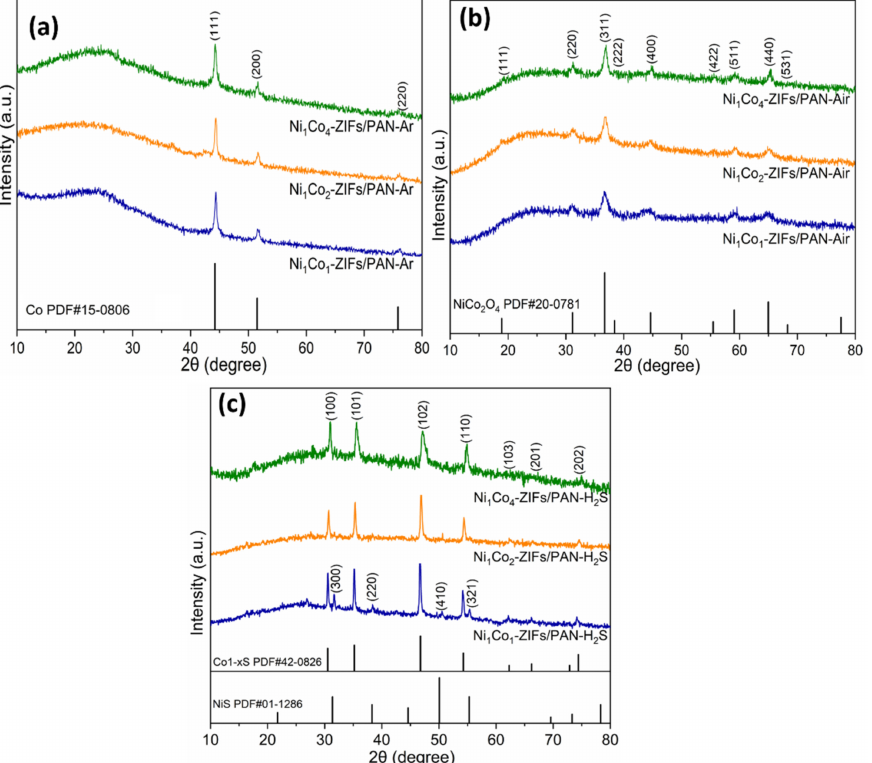
Figure 7. The XRD patterns of multi-doped porous carbon nanofibers derived from different Ni x Co y - ZIFs/PAN nanofibers by ( a ) carbonization, ( b ) oxidation, and ( c ) sulfurization in different atmo- spheres (Ar, Air, and H 2 S) at 800 ◦